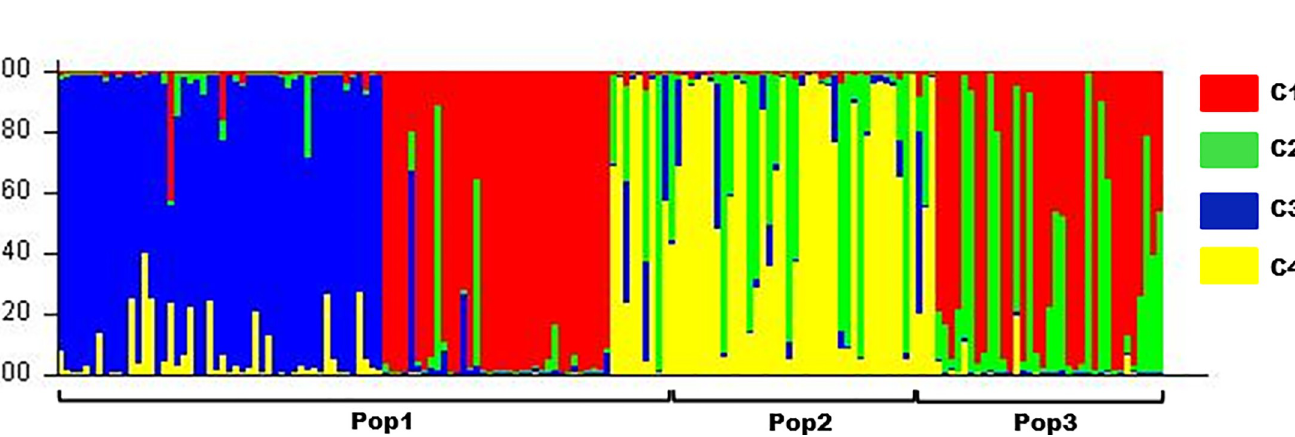
PLOS ONE | https://doi.org/10.1371/journal.pone.0228658 February 3,